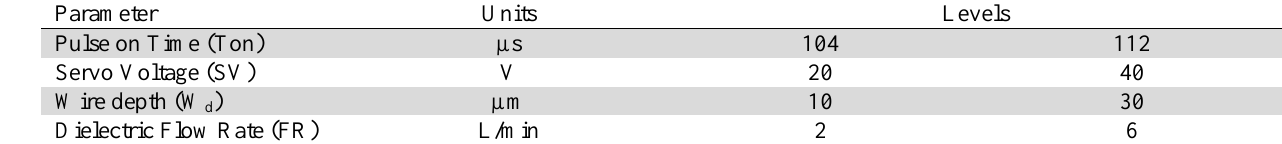
Variable process parameters and their levels for Trim cutting conditions Parameter Units Levels Pulse on Time (Ton) µs 104 112 Servo Voltage (SV) V 20 40 ) d WWire depth ( µm 10 30 Dielectric Flow Rate (FR) L/min 2